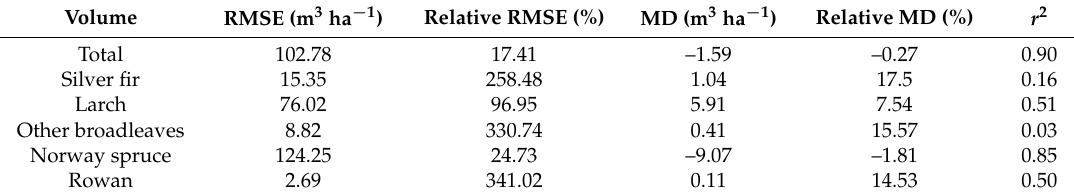
Table 5. Results of the predicted volumes derived from the semi-ITC approach extended to the plot